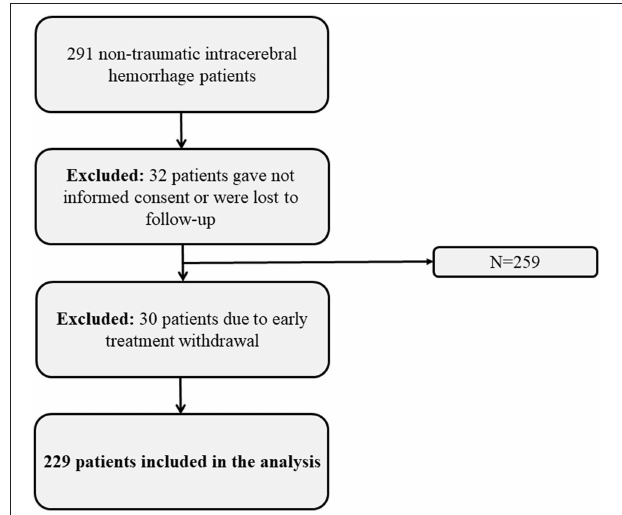
FIGURE 1 | Flow chart showing the selection of eligible